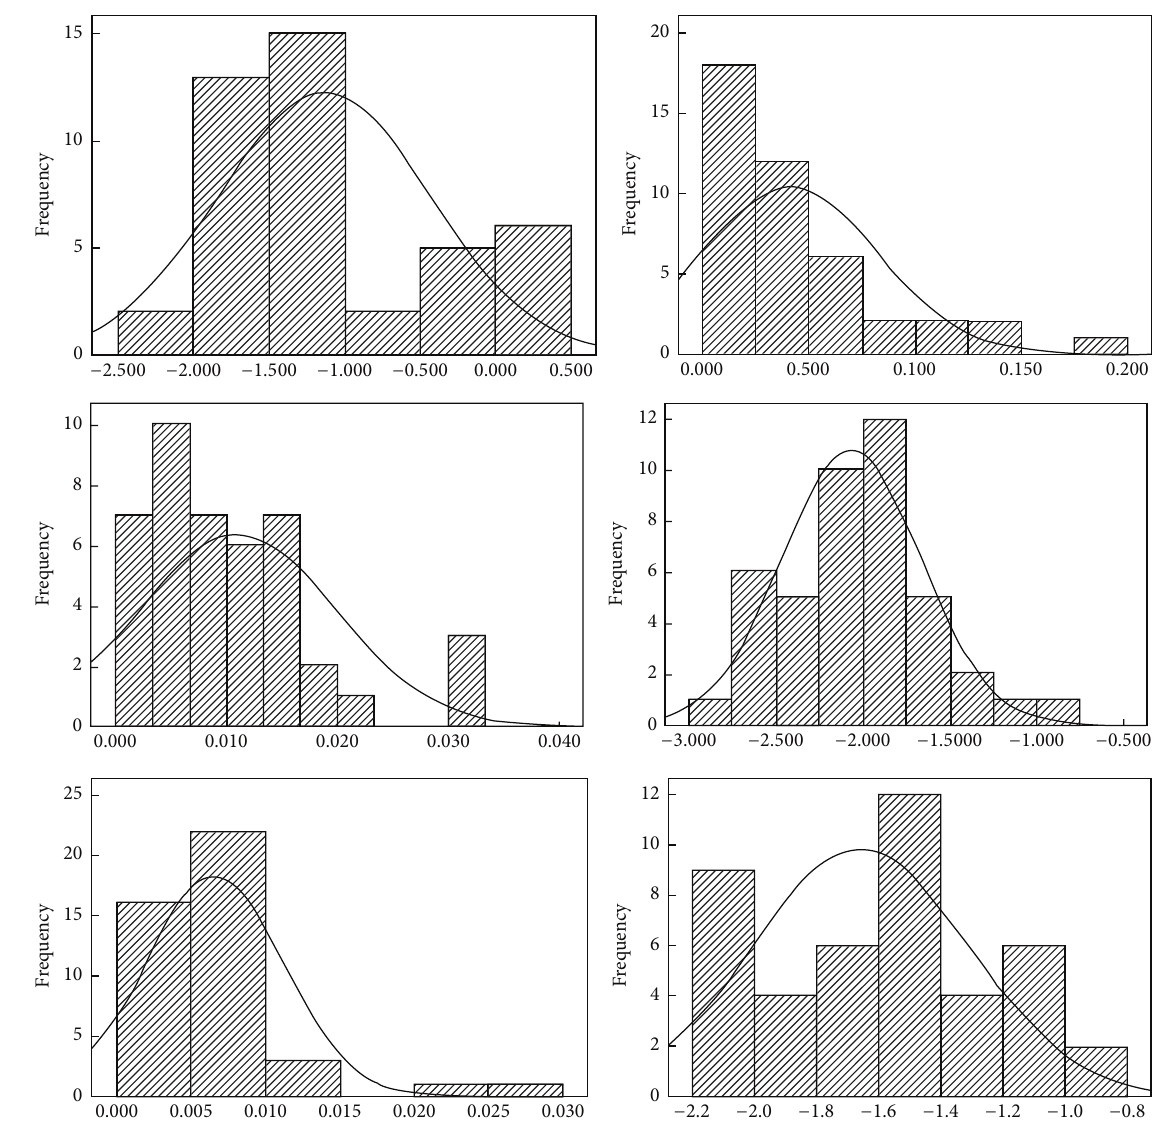
Figure 2: The metals frequency.